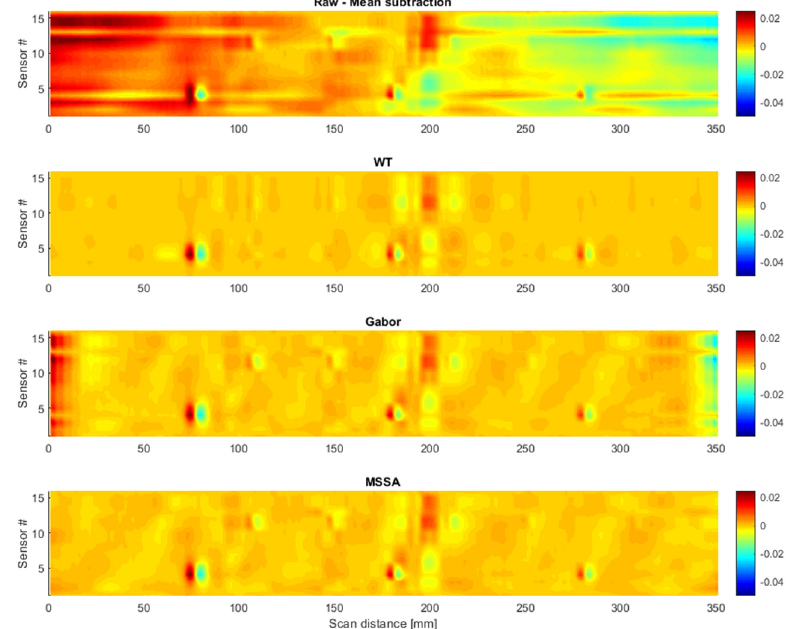
Figure 10. Magnetic scanned signal by the ECT method with the wavelet, Gabor and proposed MSSA filters.